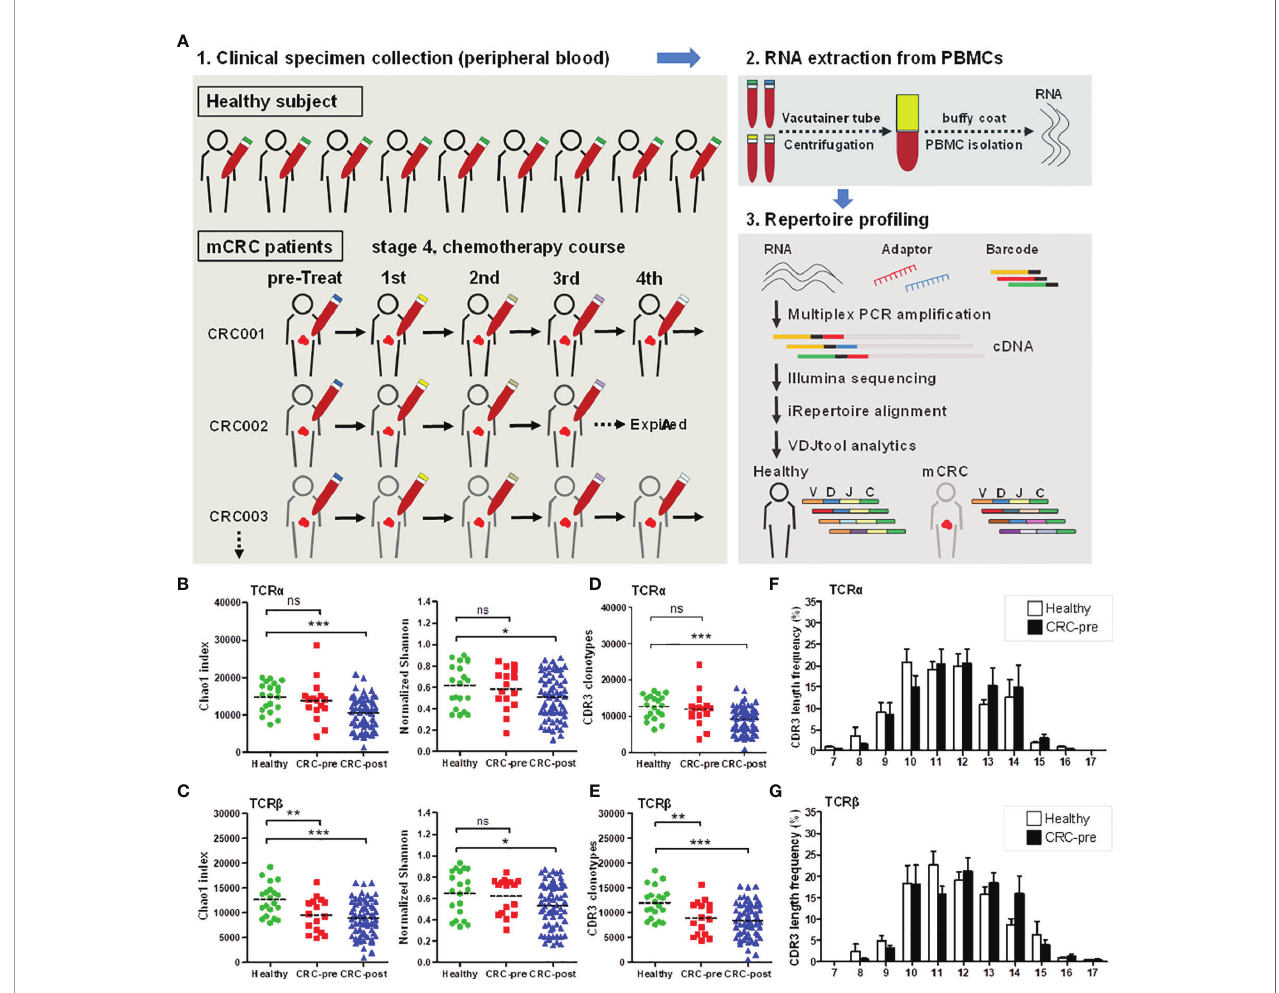
FIGURE 1 | TCR a and TCR b repertoires and CDR3 length distribution in CRC patients and healthy controls. (A) Schematic representation of the current experimental design. (B , C) The Chao1 and Shannon index of TCR a (B) and TCR b (C) repertoires in healthy controls (Healthy; green circles). CRC patients before therapy (CRC-pre; red squares), and follow-up patients with therapy (CRC-post; blue triangles) were sequenced and analyzed using VDJtools software, and the results are presented as the mean ± SEM in the column scatterplot. (D , E) TCR a (D) and TCR b (E) CDR3 clonotypes from healthy, CRC-pre, and CRC-post repertoires were determined using VDJtools analysis, and the number of CDR3 clonotypes in subjects is shown as a column scatterplot. (F , G) CDR3 coding length and frequency in healthy (white columns) and CRC-pre (black columns) TCR a (F) and TCR b (G) repertoires were obtained using VDJtools analysis, and the amino acid length spectrum (x-axis) and the corresponding frequency (y-axis) are depicted in bar graphs. Statistical signi fi cance was determined using Student ’ s t-test. ns p > 0.05, *p < 0.05, **p < 0.01, ***p <